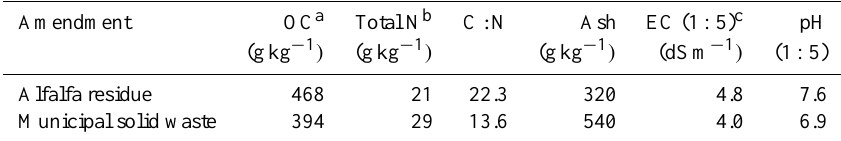
Table 2. The chemical composition of two types of amendments used in the